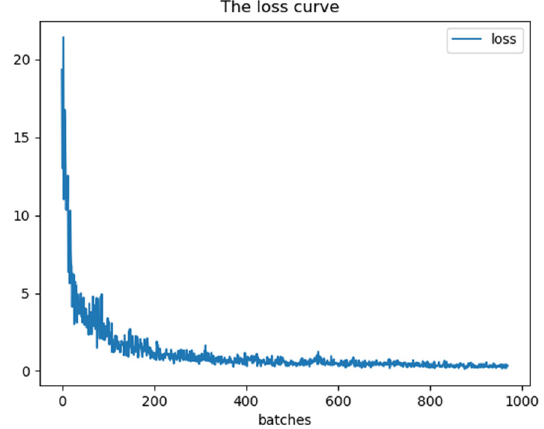
Figure 12. Loss curve in the training process.